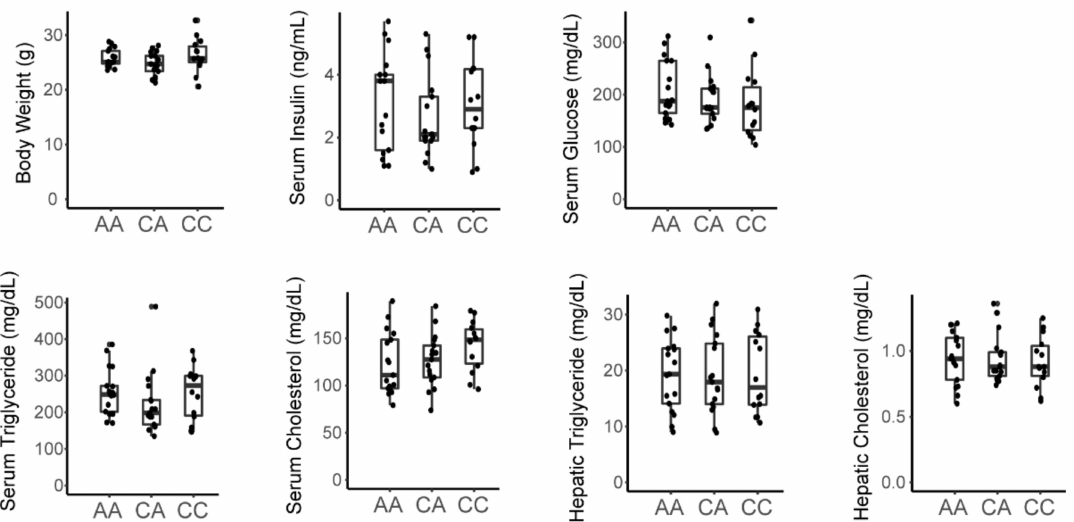
Figure 4. An inactivating missense variant in Tlr4 does not associate with metabolic traits in male fructose fed F2 mice. Genotyping performed at rs3023006 [C/A]. AA = homozygous C3H; CA = heterozygous; CC = homozygous